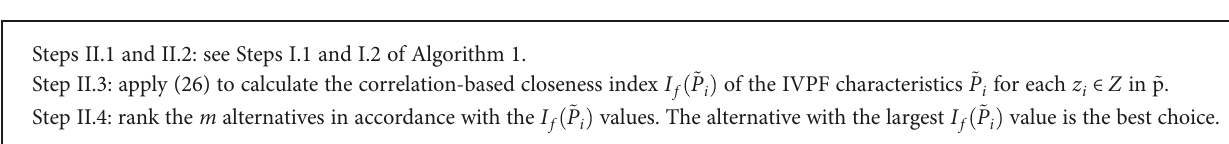
Algorithm 2: For anchored judgments with fi xed